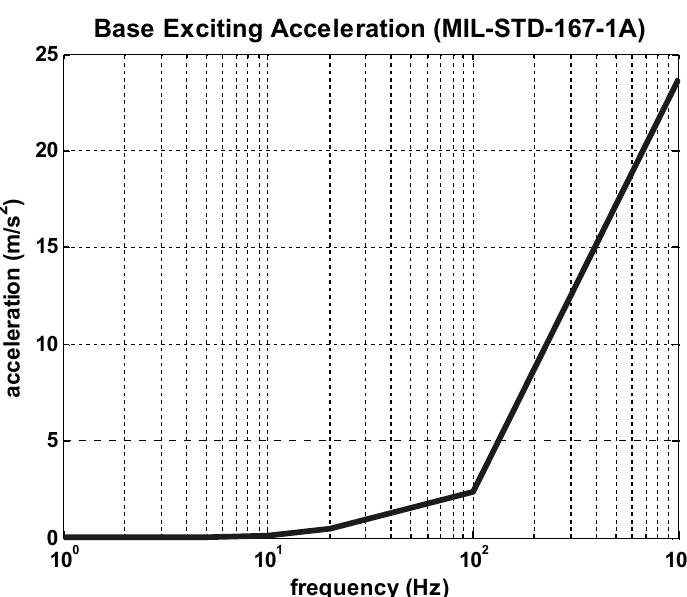
Fig. 7. Design base exciting